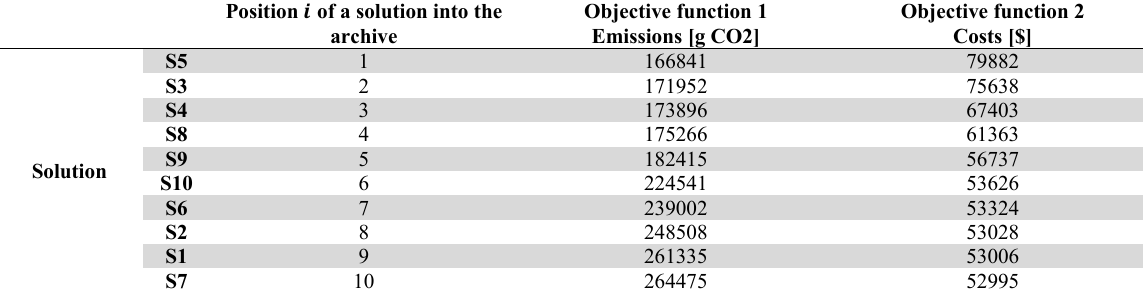
Example of a Pareto archive with contains non-dominated solutions. Own Authorship Position 𝒊 of a solution into the